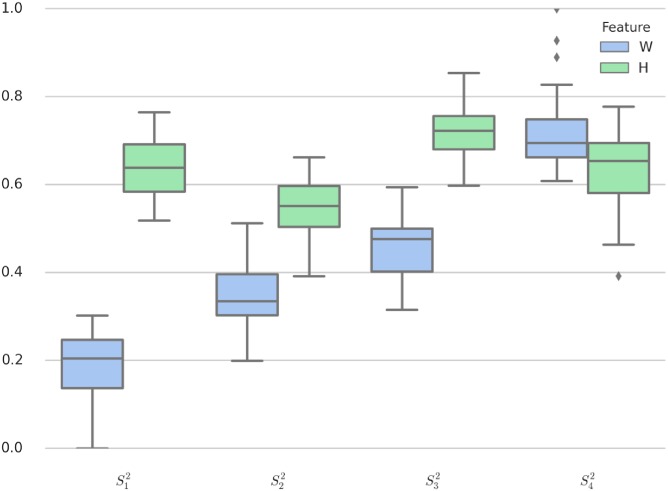
Box-plot of 2-dim clustering data.